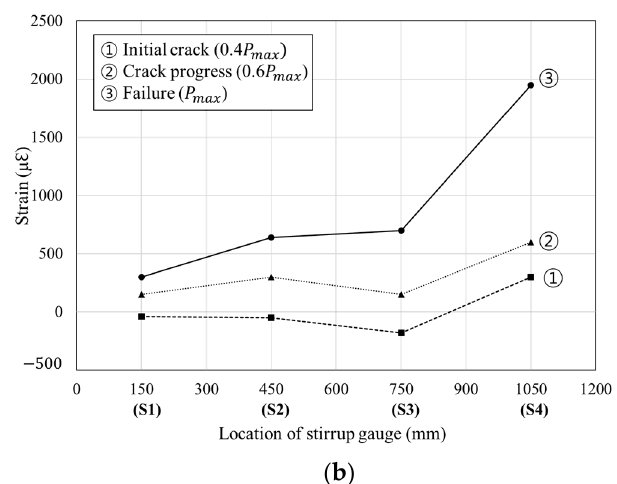
Figure 13. Strains of shear test specimens: ( a ) strain of stirrup in MCS; ( b ) strain of stirrup in PCS.